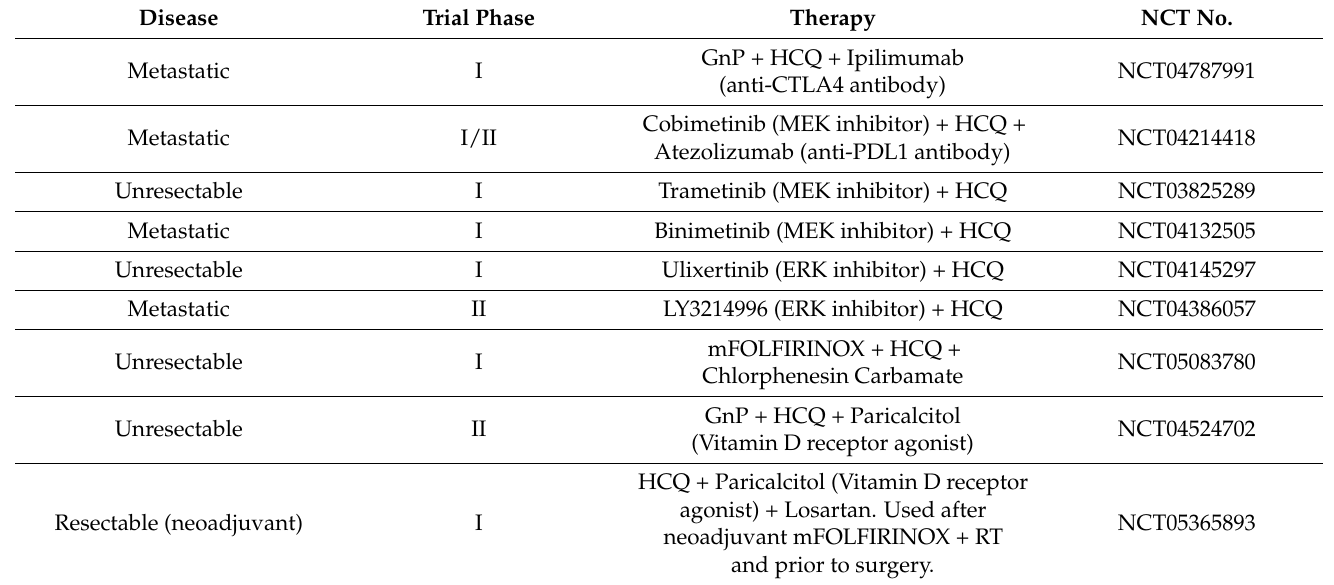
Table 1. Ongoing clinical trials targeting autophagy/lysosome in pancreatic ductal adenocarcinoma (PDAC). Disease Trial